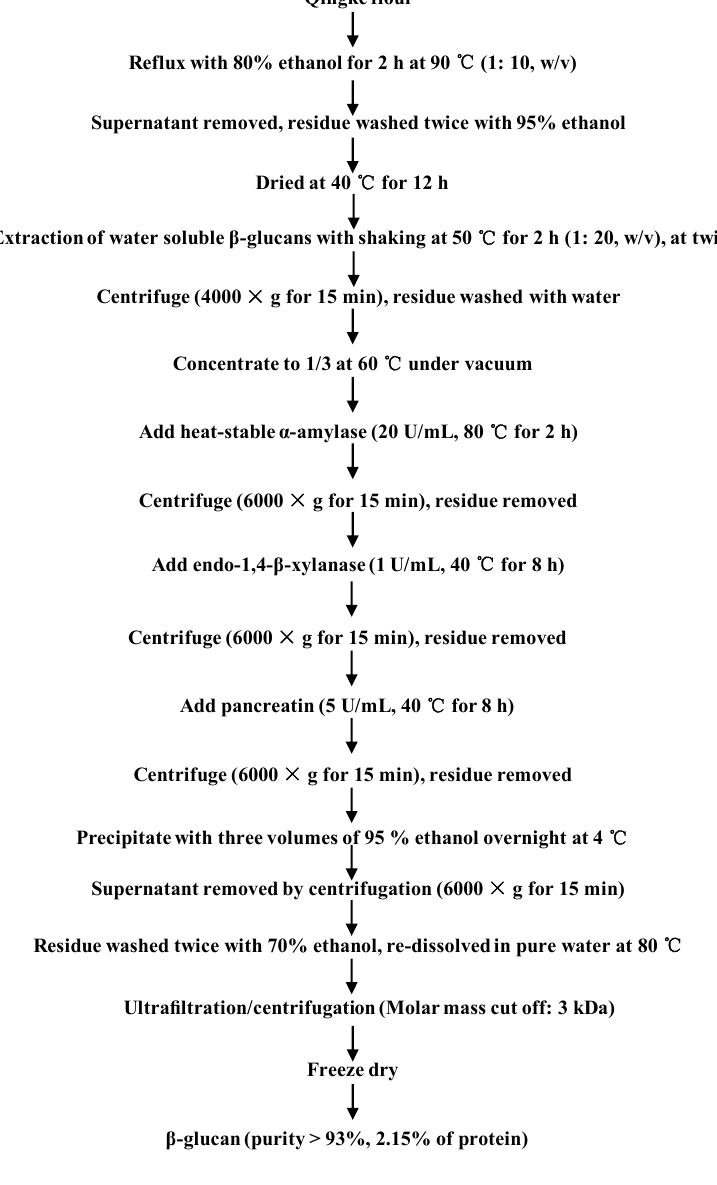
Figure 1. Flow diagram of extraction and purification of Qingke β -glucans.